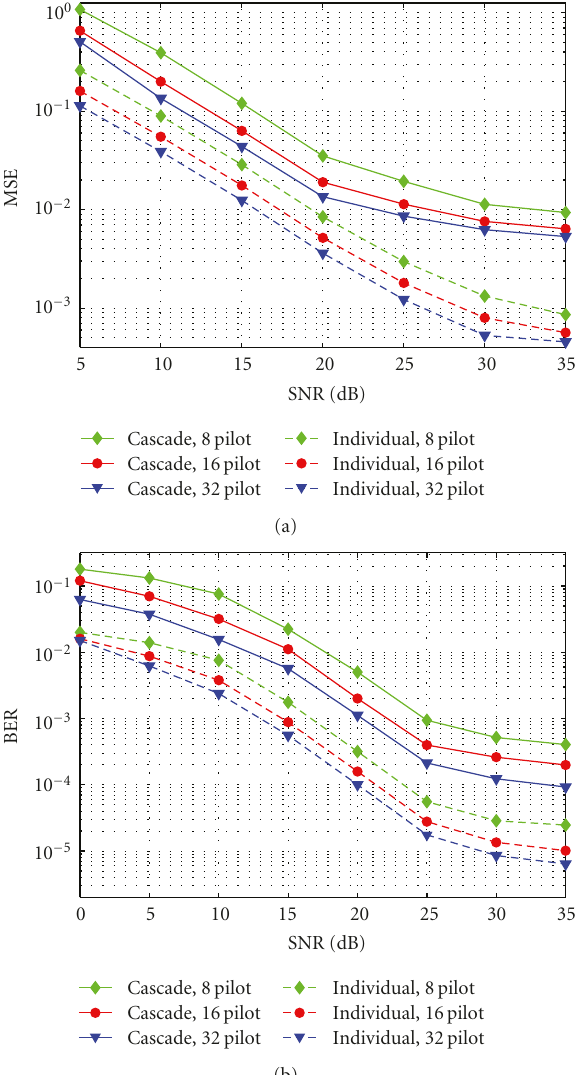
Figure 4: E ff ect of the number of pilots in both approaches. (a) Change of MSE by SNR, (b) change of BER by